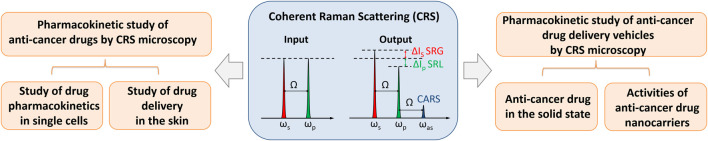
Schematic showing coherent Raman scattering (CRS) microscopy and its application in oncology pharmacokinetics. When tuning the beating frequency (ω
p-ω
s) to match molecular vibration frequency Ω, multiple Raman transitions were excited simultaneously, including stimulated Raman gain (SRG), stimulated Raman loss (SRL), and coherent anti-Stokes Raman scattering (CARS). ω
p, ω
s, and ω
as denote the frequencies of the pump, Stokes, and anti-Stokes beam, respectively. CRS microscopy has shown great potential in the investigation of anti-cancer drug pharmacokinetics, anti-cancer drug stability and dissolution in the solid state, and activities of anti-cancer drug nanocarriers in single cells.